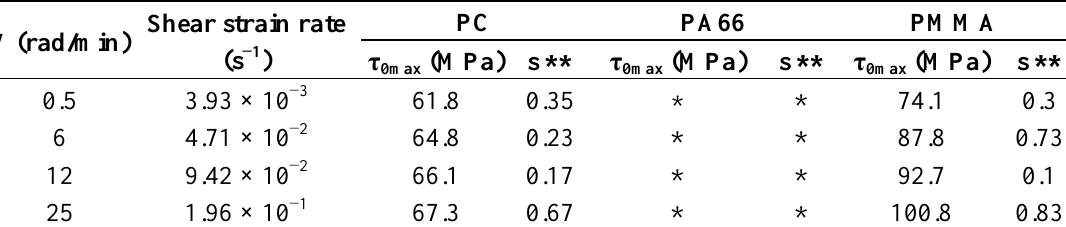
Table 3. Yield shear stresses τ